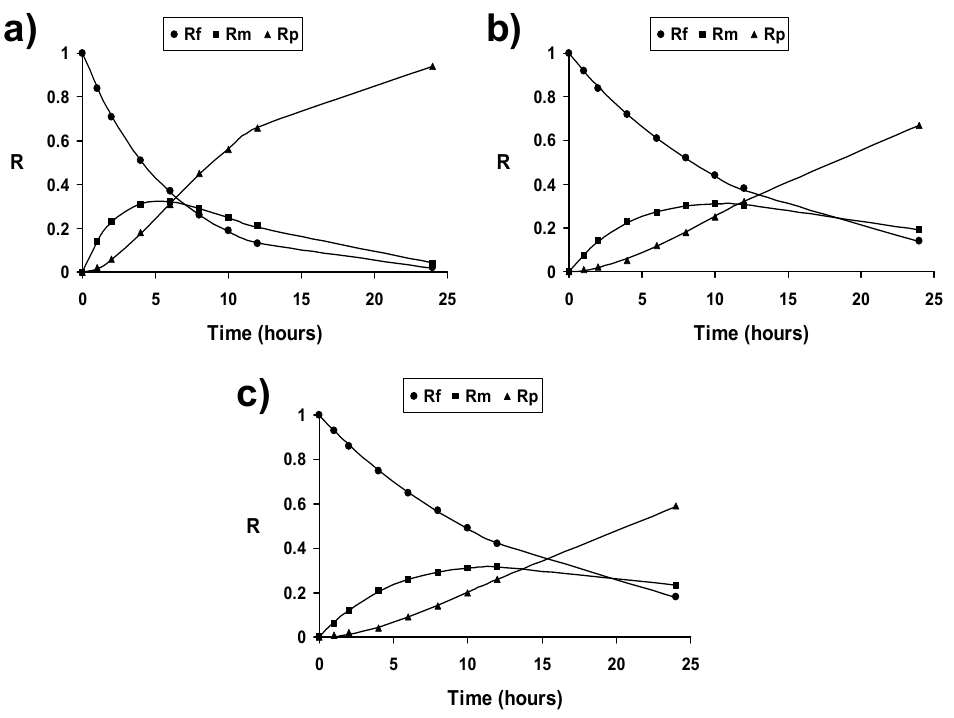
Figure 4. Time dependence of R f in feed phase, R m in membrane phase, and R p in product phase in the facilitated counter transport of Cu(II) using benzoylacetone ( a ), 8-hydroxyquinoline ( b ), and tri- n- octylamine ( c ) as carriers. (Points, experimental values; line, model values).